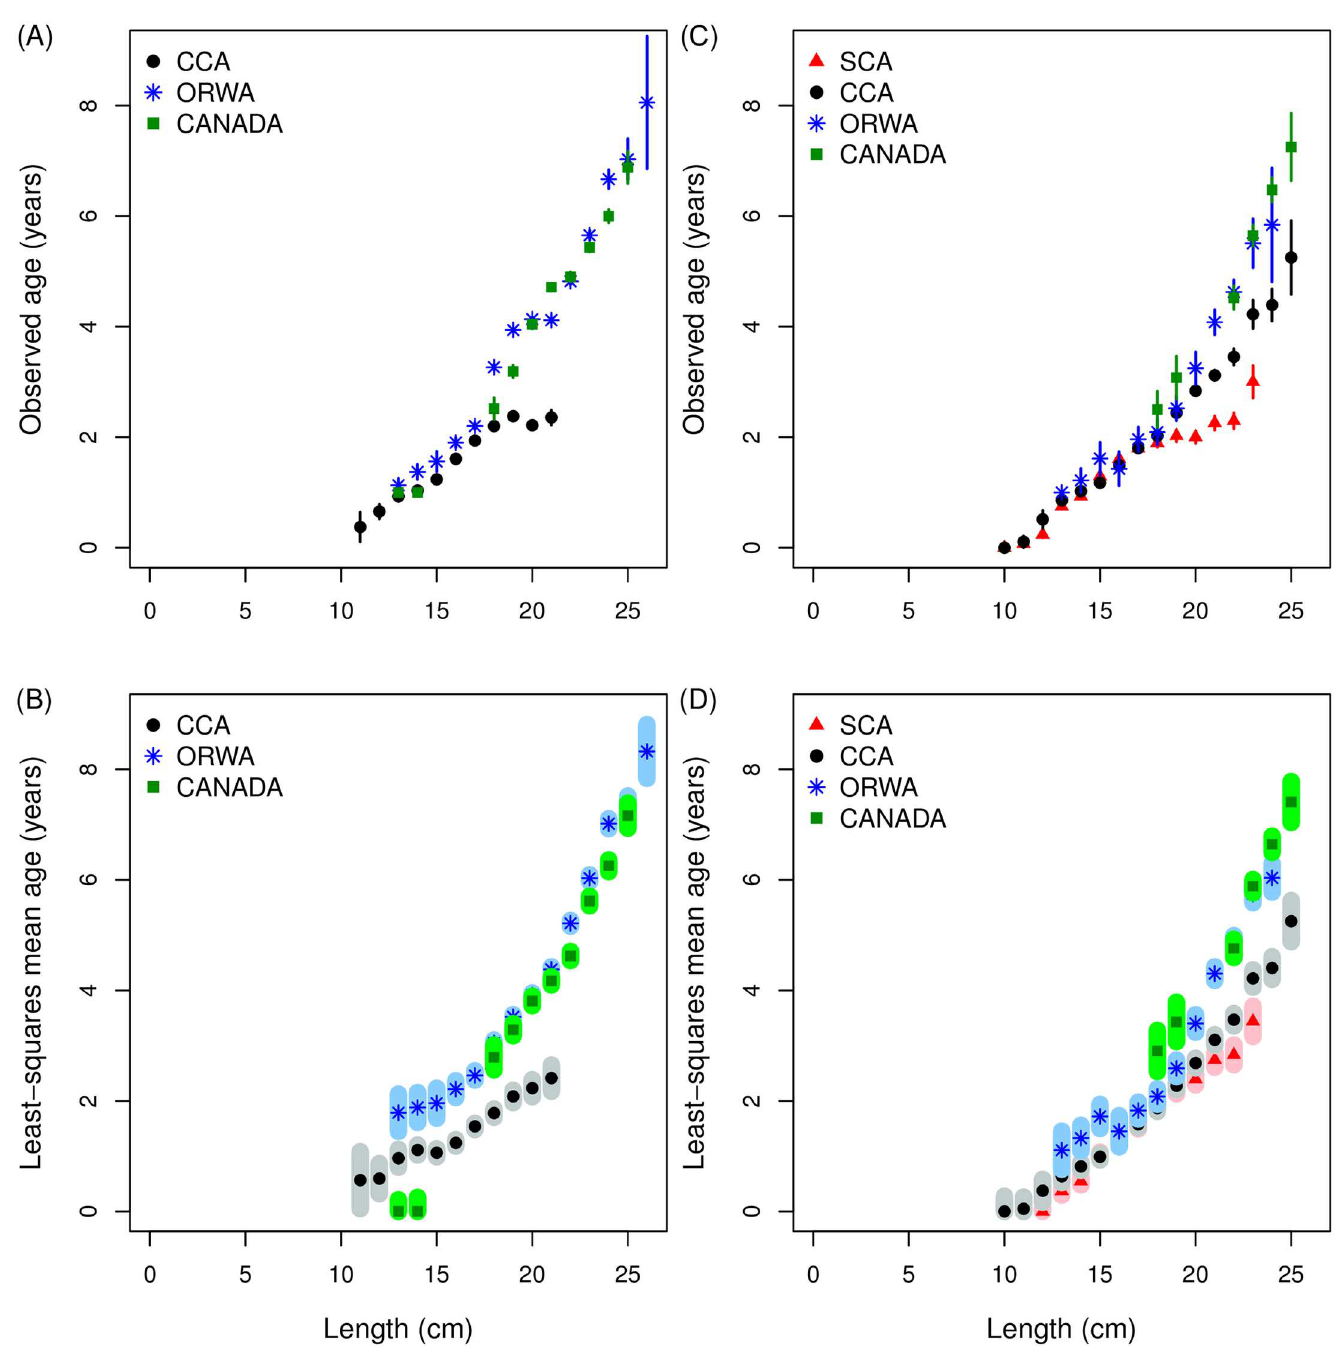
Fig 3. Observed mean age-at-length and least-squares mean age-at-length for quarter 3 (July-September) and quarter 4 (October-December) from 1981–2010. (A) Quarter 3 observed mean age-at-length; and (B) least-squares mean age-at-length for central California (CCA, ● ), the Columbia River basin (ORWA, * ), and Canada(CANADA, ■ ); (C) Quarter 4 observedmean age-at-length; and (D) least-squares mean age-at-length for Southern California (SCA, ▲ ), central California (CCA, ● ), the ColumbiaRiver basin (ORWA, * ), and Canada(CANADA, ■ ) where the error bars in the upper panelsindicate the 95% confidenceintervals of the observations and shadedareas in the lower panelsrepresent 95% confidenceintervals of the